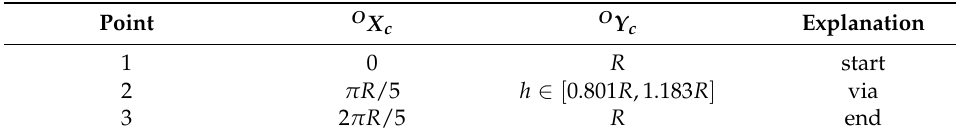
Figure 7. Distribution of the initial point, via points, and end point for CoM trajectory planning. Table 1. The position defined for the trajectory planning. Point O X c O Y c Explanation